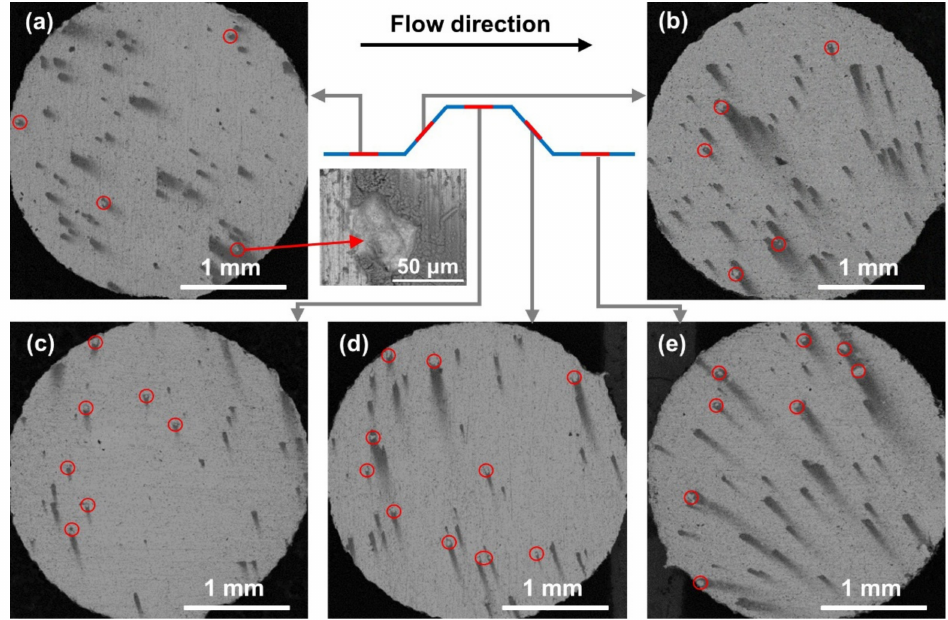
Figure 8. SEM corrosion morphologies of the samples located on ( a ) upstream surface, ( b ) incident flow surface, ( c ) top surface, ( d ) backflow surface, and ( e ) downstream surface of the WRH with corrosion products after 6 h flow